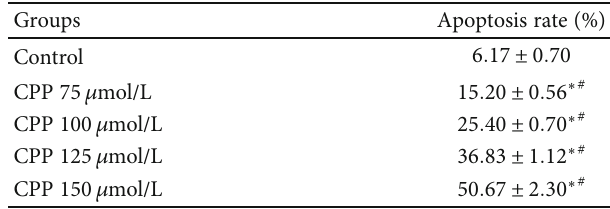
Figure 4: CPP induces apoptosis of U251 cells. Compared with the control group, ∗ indicates p < 0 : 05 . Comparison between treatment groups with di ff erent concentrations of CPP (75, 100, 125, and 150 μ mol/L), # indicates p < 0 : 05 . This experiment was repeated three times independently. Table 2: Apoptosis of U251 cells under di ff erent concentrations of average CPP